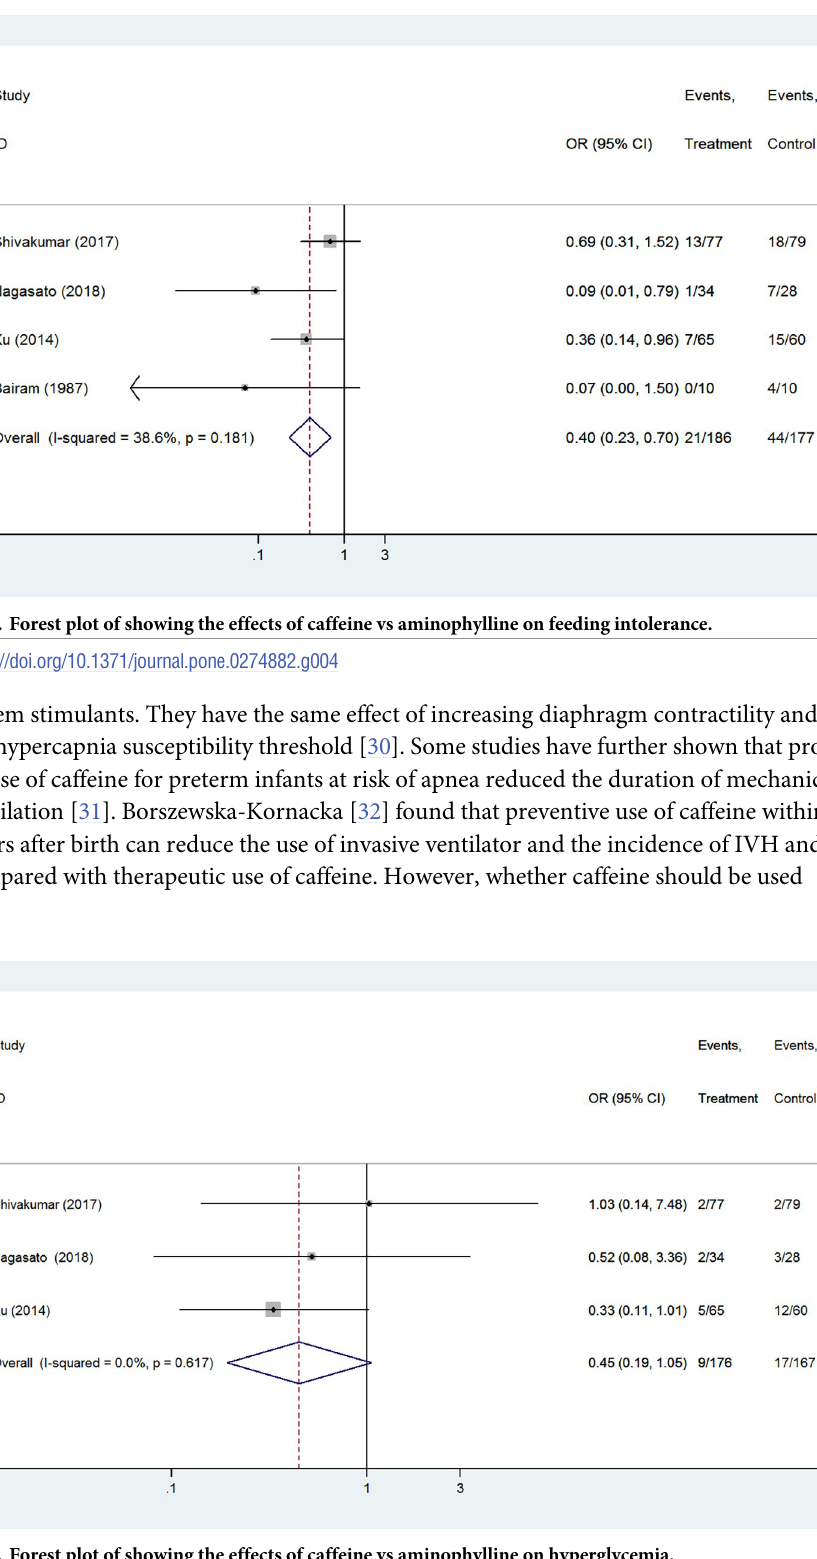
Fig 5. Forest plot of showing the effects of caffeine vs aminophylline on hyperglycemia.